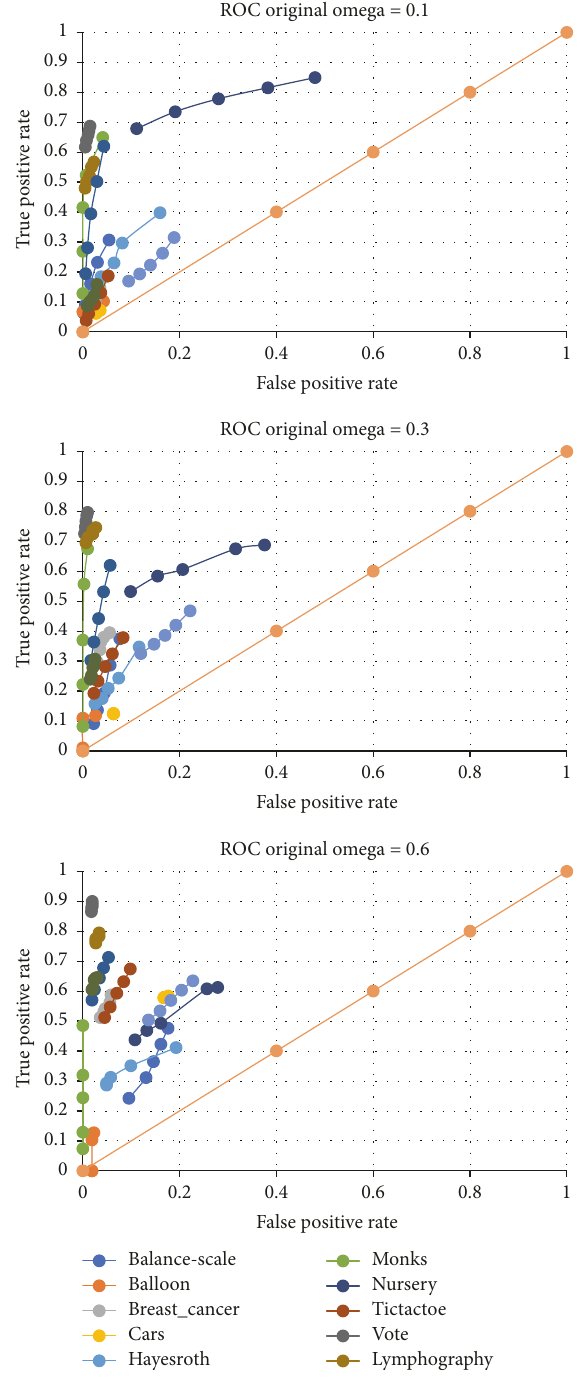
Figure 7: ROC for all parameter combinations.